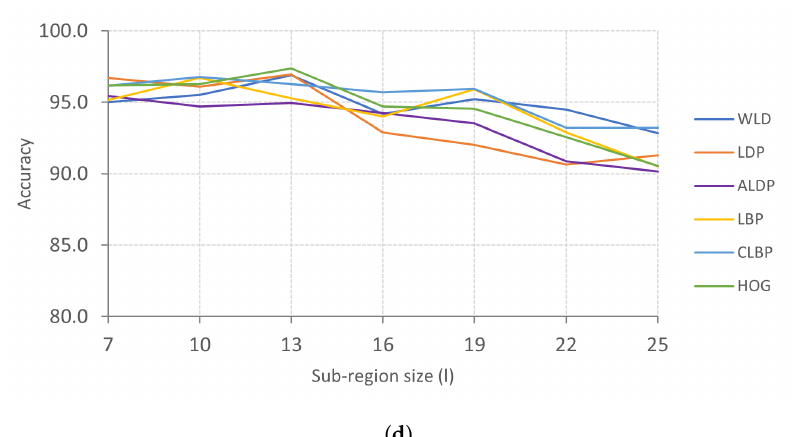
Figure 5. FER results for different sub-regions sizes on RFD with 6 expressions ( a ) SVM results; ( b ) NB results; ( c ) KNN results; ( d ) MLP results. Table 3. Best parameters for each combination of classifier and descriptor (number of bins, block